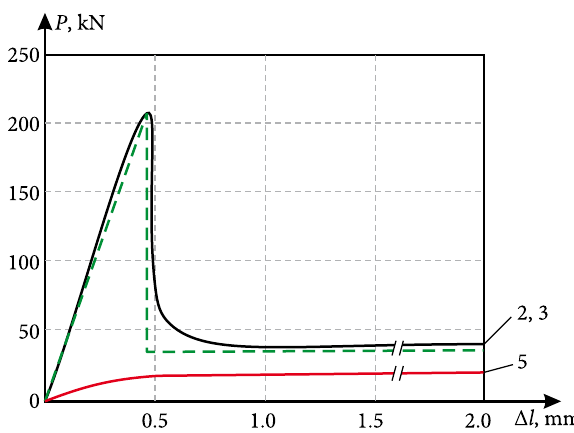
Fig. 5. Behaviour of steel tape and composite material on the bases of two steel and one CFRP tapes: designitions as in Fig.